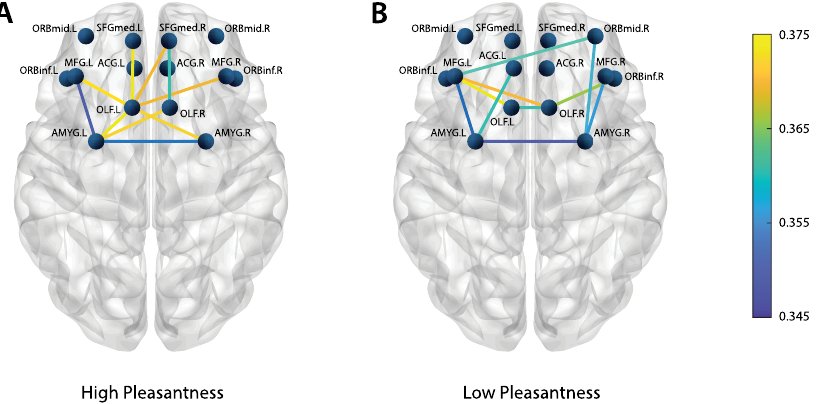
Figure 6. Top 10 strongest connections (from the wPLI adjacency matrices) within the hedonic olfactory model, averaged across subjects and trials. (Panel A ) shows the high-pleasantness condition, (panel B ) the low-pleasantness counterpart. Beta band ([13–30] Hz) results are